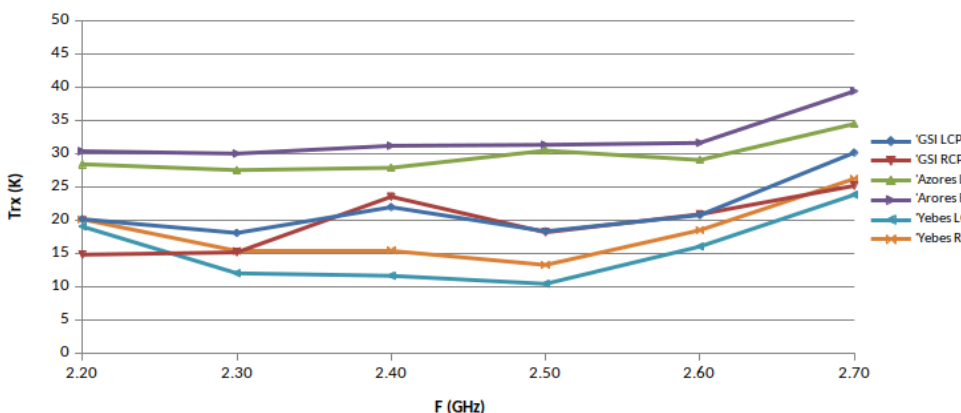
Figure 14. S-band receiver noise temperatures.